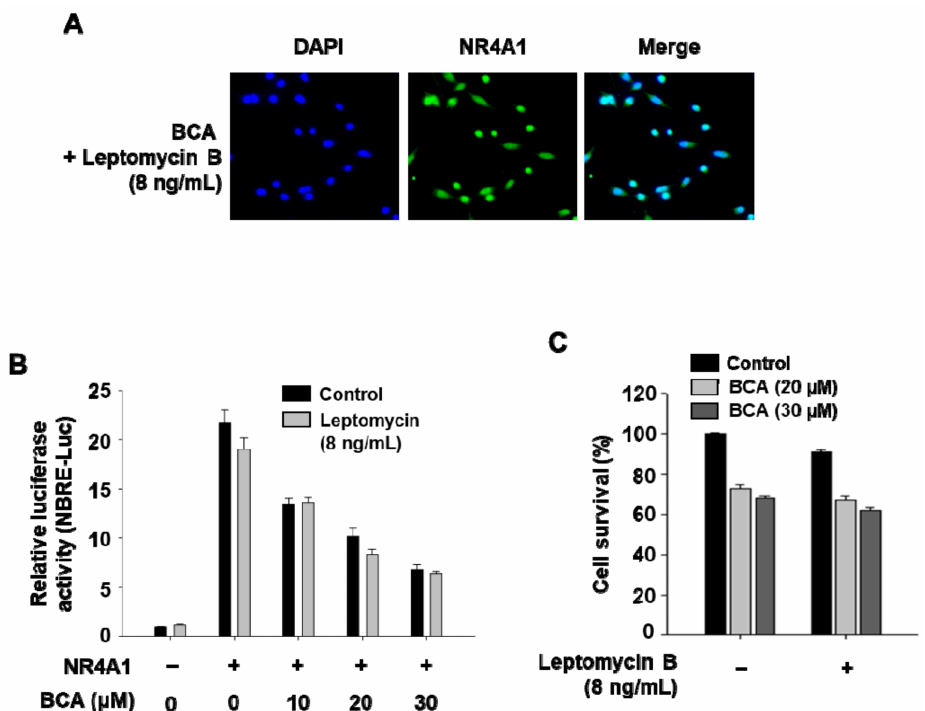
Figure 2. Blockage of the nuclear export of NR4A1 has no effect on BCA-mediated inhibition of NR4A1 transactivation and cell growth in pancreatic cancer cells. ( A ) Subcellular localization of NR4A1. MiaPaCa-2 cells were treated with BCA (20 µ M) in the presence or absence of leptomycin B for 3 h, and endogenous NR4A1 was stained and visualized as described in the Section 3. ( B ) Cells were transfected with NBRE-Luc (25 ng) for 5 h and then treated with BCA in the presence or absence of leptomycin B for 18 h. Luciferase activity (relative to β -galactosidase) was determined, and the corresponding empty vector was used as a control. ( C ) Cells were treated with BCA in the presence or absence of leptomycin B for 24 h, and cell viability was determined as described in the Section 3. The results are presented as means ± SEM. No significant difference was observed between BCA alone and BCA + leptomycin